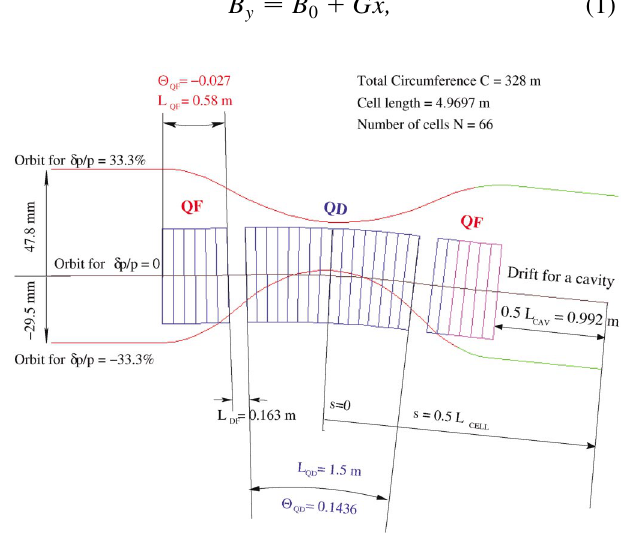
FIG. 1. (Color) Basic half cell. The cell is symmetric with respect to s (cid:1) 0 . The total length of the cell equals L (cid:5) 2 (cid:6) L (cid:5) L (cid:5) 2 (cid:6) L L . There are two types of QF QD DF cavity (cid:1) 4 : 95 T ) and QF (nega- magnets, QD (normal bend, field B QD (cid:1) (cid:3) 2 : 29 T ). Each has constant gradient, tive bend, field B QF (cid:1) 57 : 19 T = m and G (cid:1) (cid:3) 34 : 27 T = m G QF QD